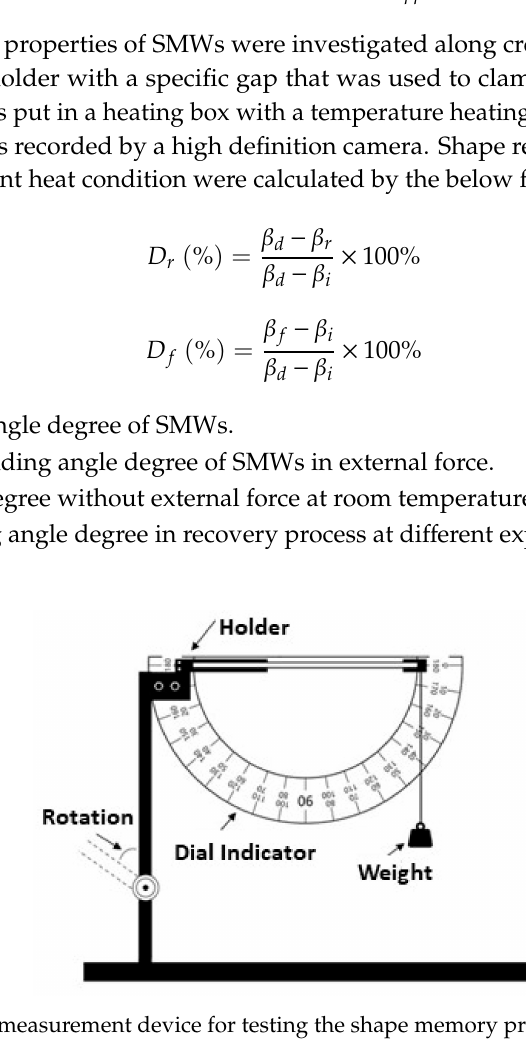
Figure 1. Angle measurement device for testing the shape memory properties of